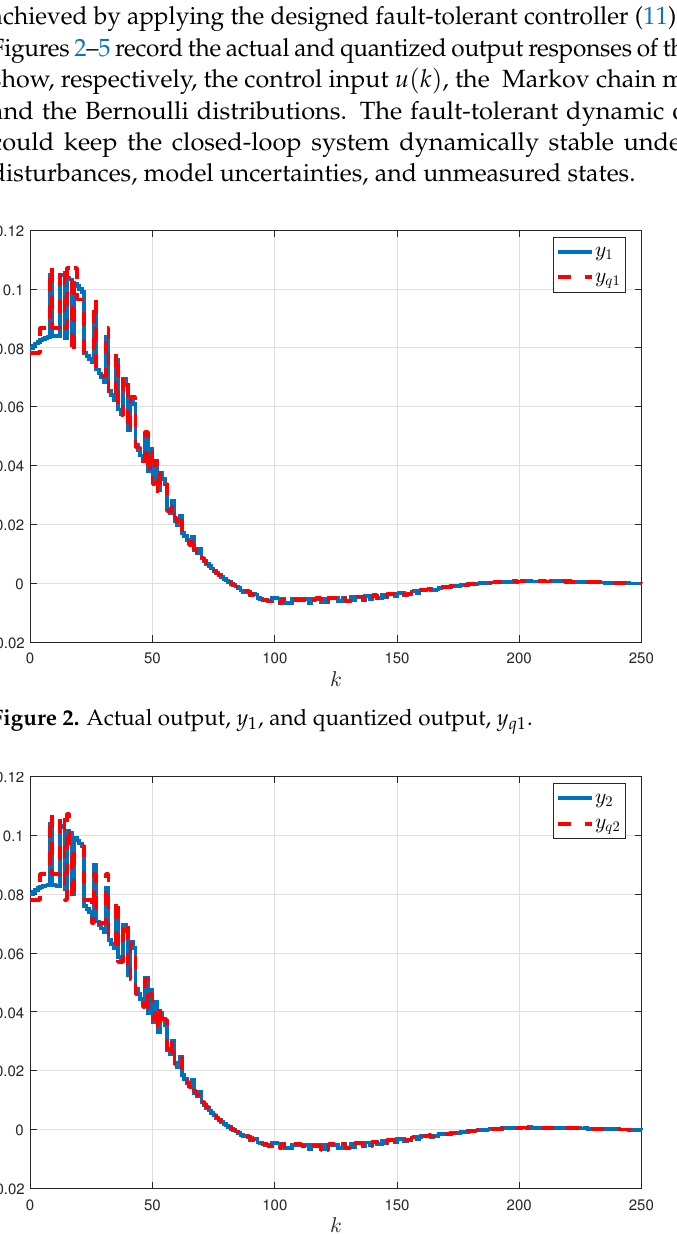
Figure 3. Actual output, y 2 , and quantized output, y q 2